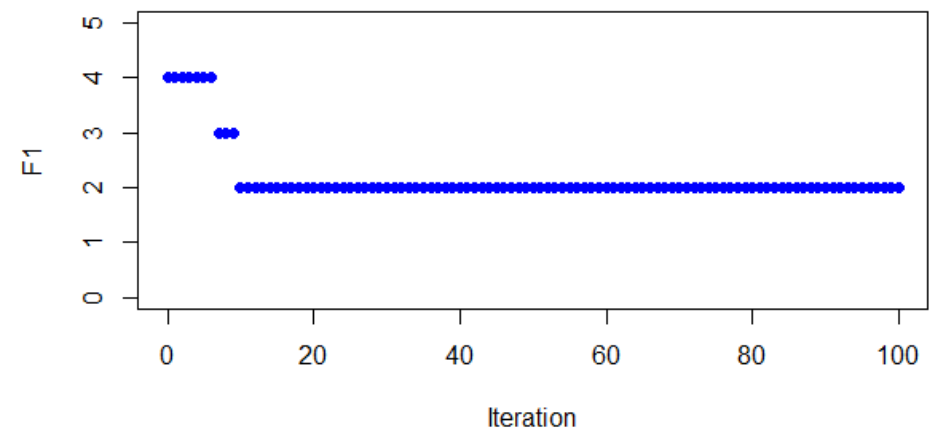
Figure 2. Illustrating the convergence of BONXEA regarding F 1